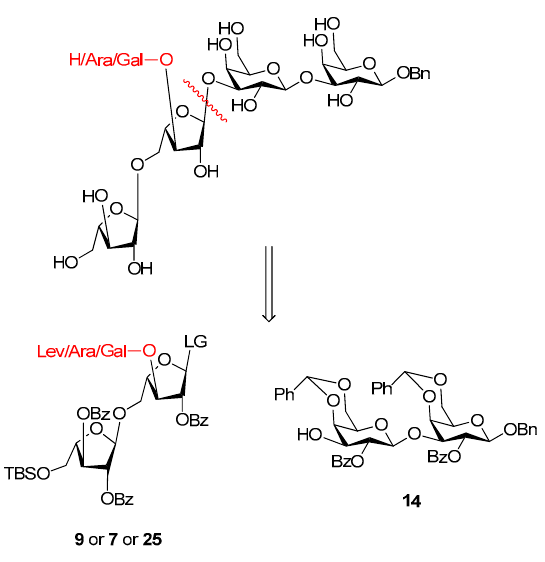
Figure 2. Retrosynthetic analysis of three branches derived from RN1. Bz = benzoyl, Bn = benzyl, Lev = levulinoyl, TBS = t -butyldimethylsilyl.